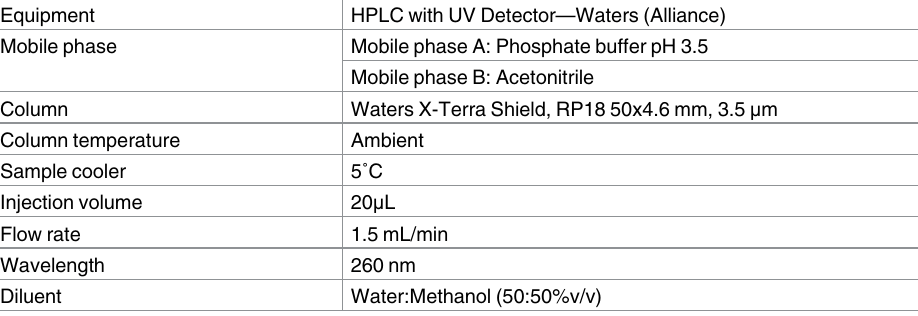
Table 2. Optimized chromatographic